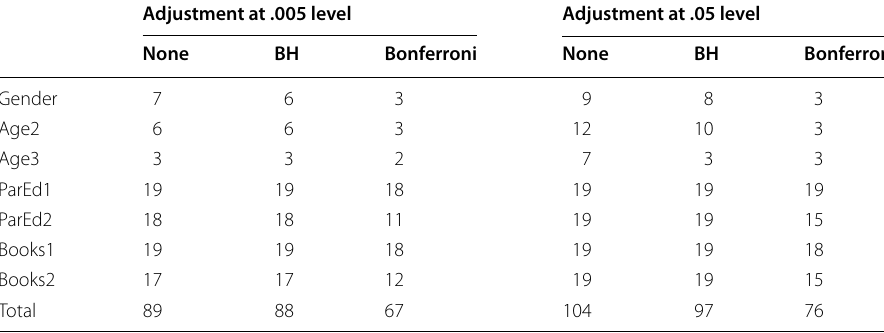
Table 5 Counts of discoveries for KHB differences, by variable [Q4] Adjustment at .005